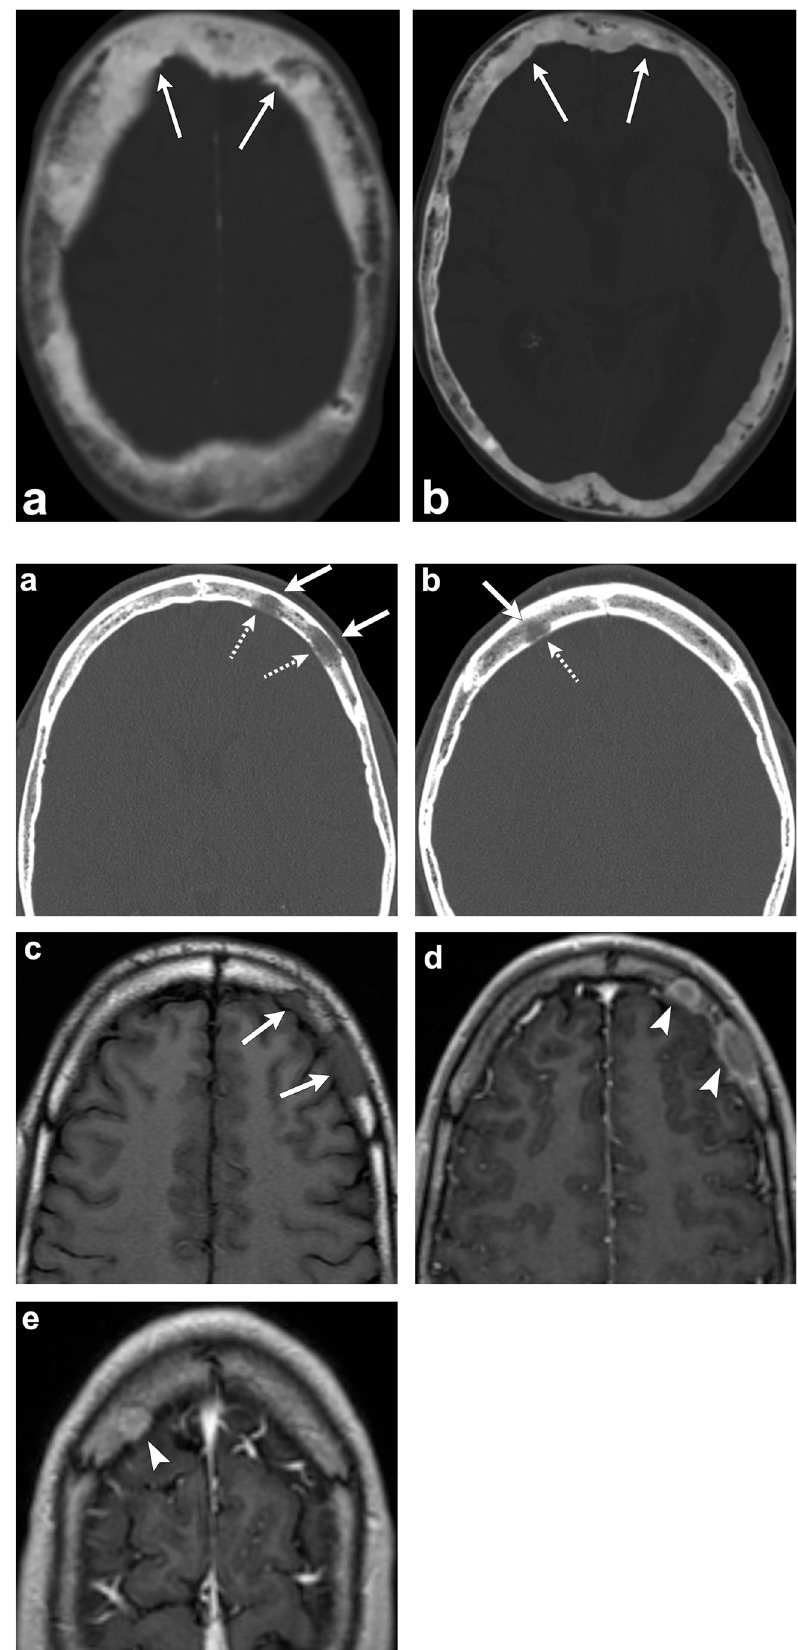
Fig. 10 Paget disease. Axial head CT ( a , b ) images demonstrate increased cortical density and trabecular thickening ( arrows